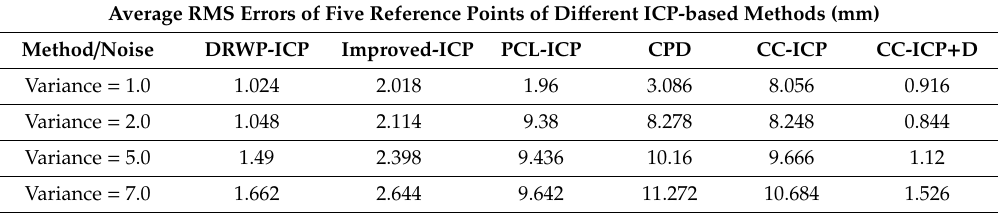
Table 10. The Average, Minimum and Maximum of Reference Points’ Alignment Errors.